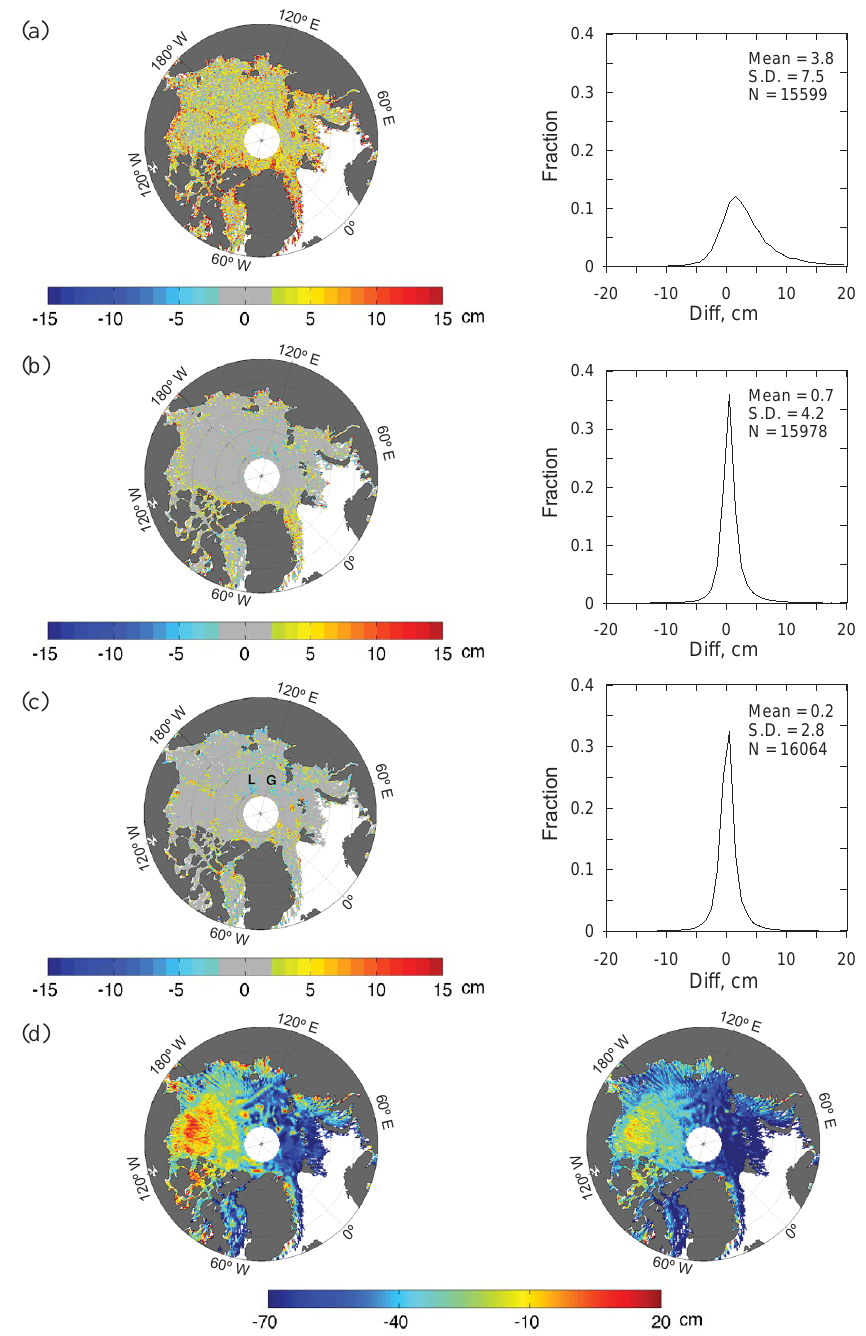
Figure 3. Effect of using different geoids and scales for along-track averaging on freeboard estimates (cm) when applying the LLE method for FM06 period (25km grids). Differences between freeboard estimates show the effects of (a) applying longer and shorter along-track averaging scales (longer minus shorter) when using EGM08 geoid as well as (b) adjustment of ArcGP geoid for ¯ h − h sl values (adjusted minus unadjusted) and (c) using different geoids (EGM08 minus ArcGP) in case of applying longer along-track averaging scales. (d) Adjustment for ¯ h − h sl to correct ArcGP (left) and EGM08 (right) geoids when using coarser resolutions (cm). G and L in (c) point out the location of the differences along the Gakkel and Lomonosov